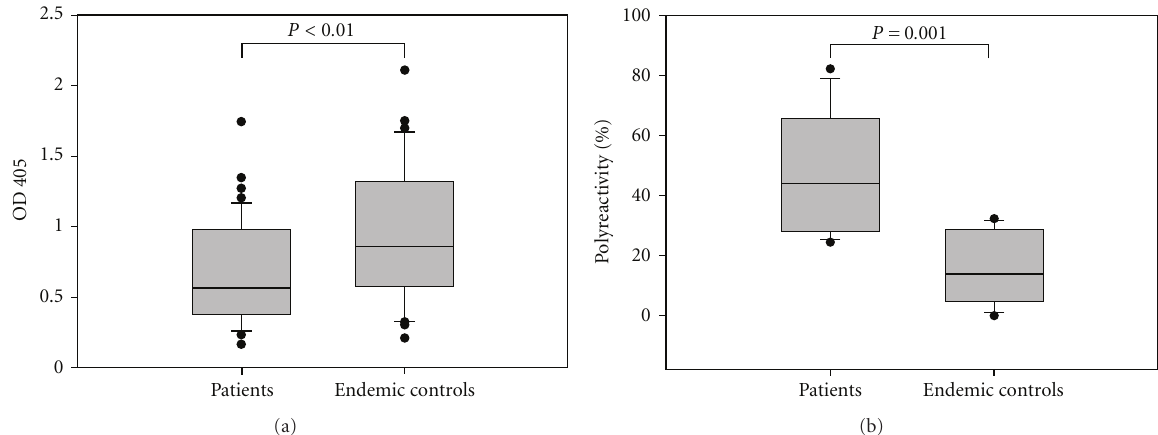
Figure 6: Polyreactive serum anti-PfP0C0 response observed in uncomplicated malaria patients, but not in immune adults living in high endemicity areas. (a) Box plots showing the 25th and 75th percentiles, together with the median, with whiskers showing the minimum and maximum di ff erence and filled circles representing the outliers in anti-PfP0 responses of sera from patients of uncomplicated malaria ( n = 49) and immune adults ( n = 30) as determined in ELISA. (b) Box plots showing the 25th and 75th percentiles, together with the median, with whiskers showing the minimum and maximum di ff erence and filled circles representing the outliers of % polyreactivity in anti-PfP0 responses of sera from patients and immune adults. The sera were treated or not with DNP-sepharose beads, and anti-PfP0 titre before and after treatment was determined in ELISA to determine the %